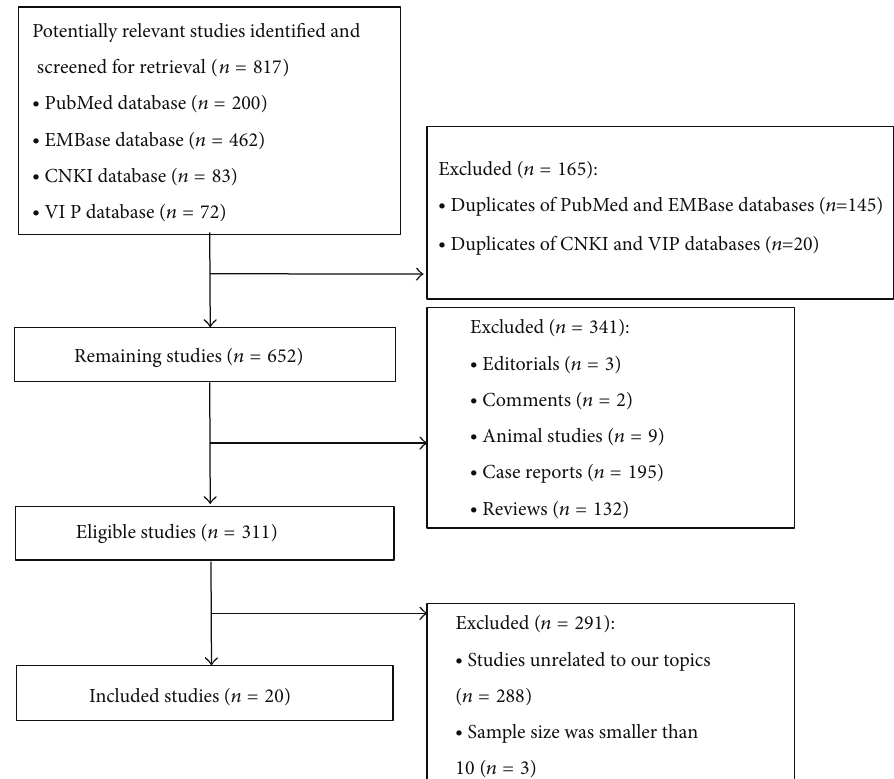
Figure 1: Flowchart for the literature search. Abbreviations: CNKI, China National Knowledge Infrastructure; VIP, Chinese Scientific and Technological Journal.